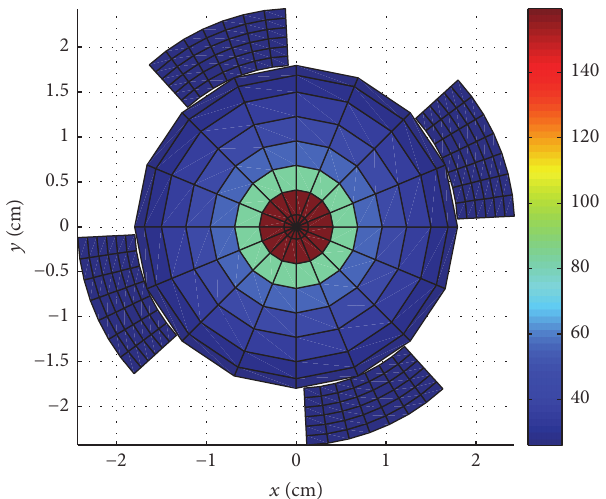
Figure 4: The crosscutting map of the LED heat sink considered in this